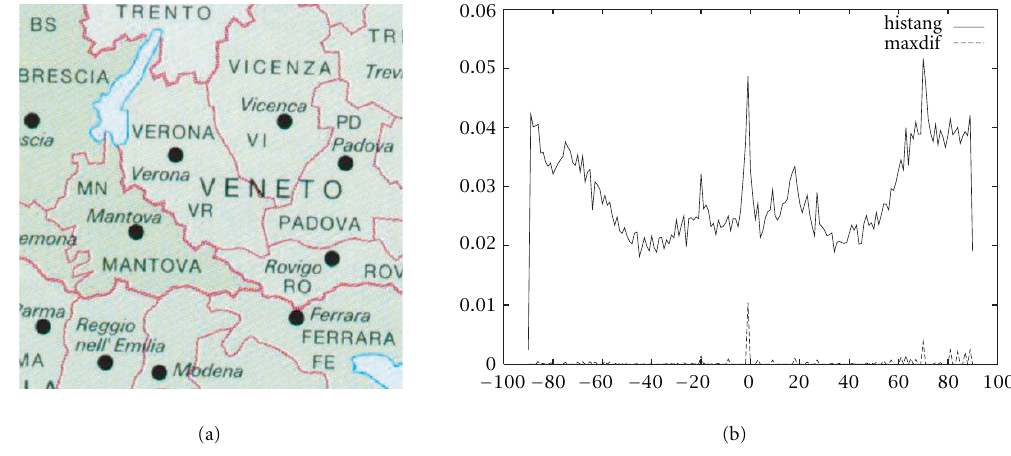
Figure 7: A rotated map image (a) and the corresponding plot of λ(θ i ) , solid line, and p(θ i ) , dashed line. Only the maximum of p(θ i ) permits to determine the true text orientation ( − 1